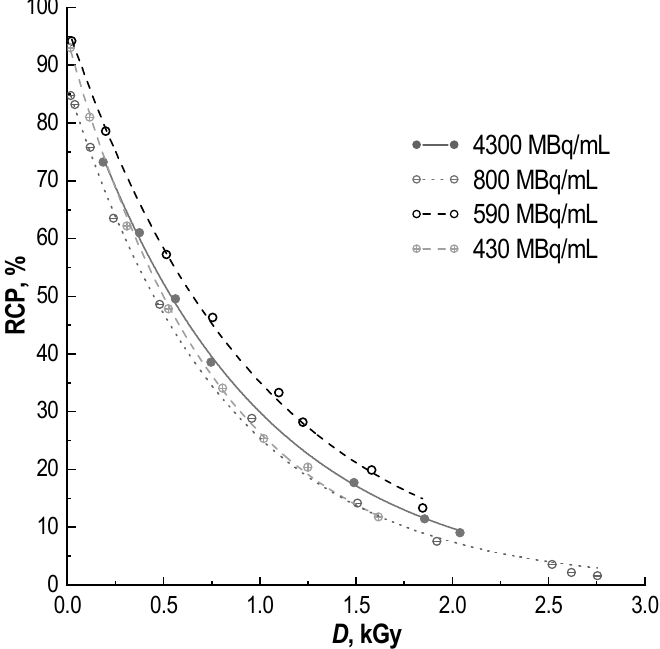
Figure 5. The dependence of the [ 177 Lu]Lu-PSMA-617 radiochemical purity on the absorbed dose for different activity concentrations (samples volume—1 mL, 100 µ g of PSMA-617, pH 4.5, C(Na-acetate) = 0.03 mol/L; error bars are omitted for clarity).